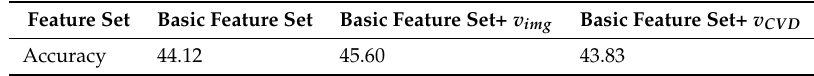
Table 4. Classification results comparing the use of estimated mean gait velocity from the CVD and velocity-time diagram